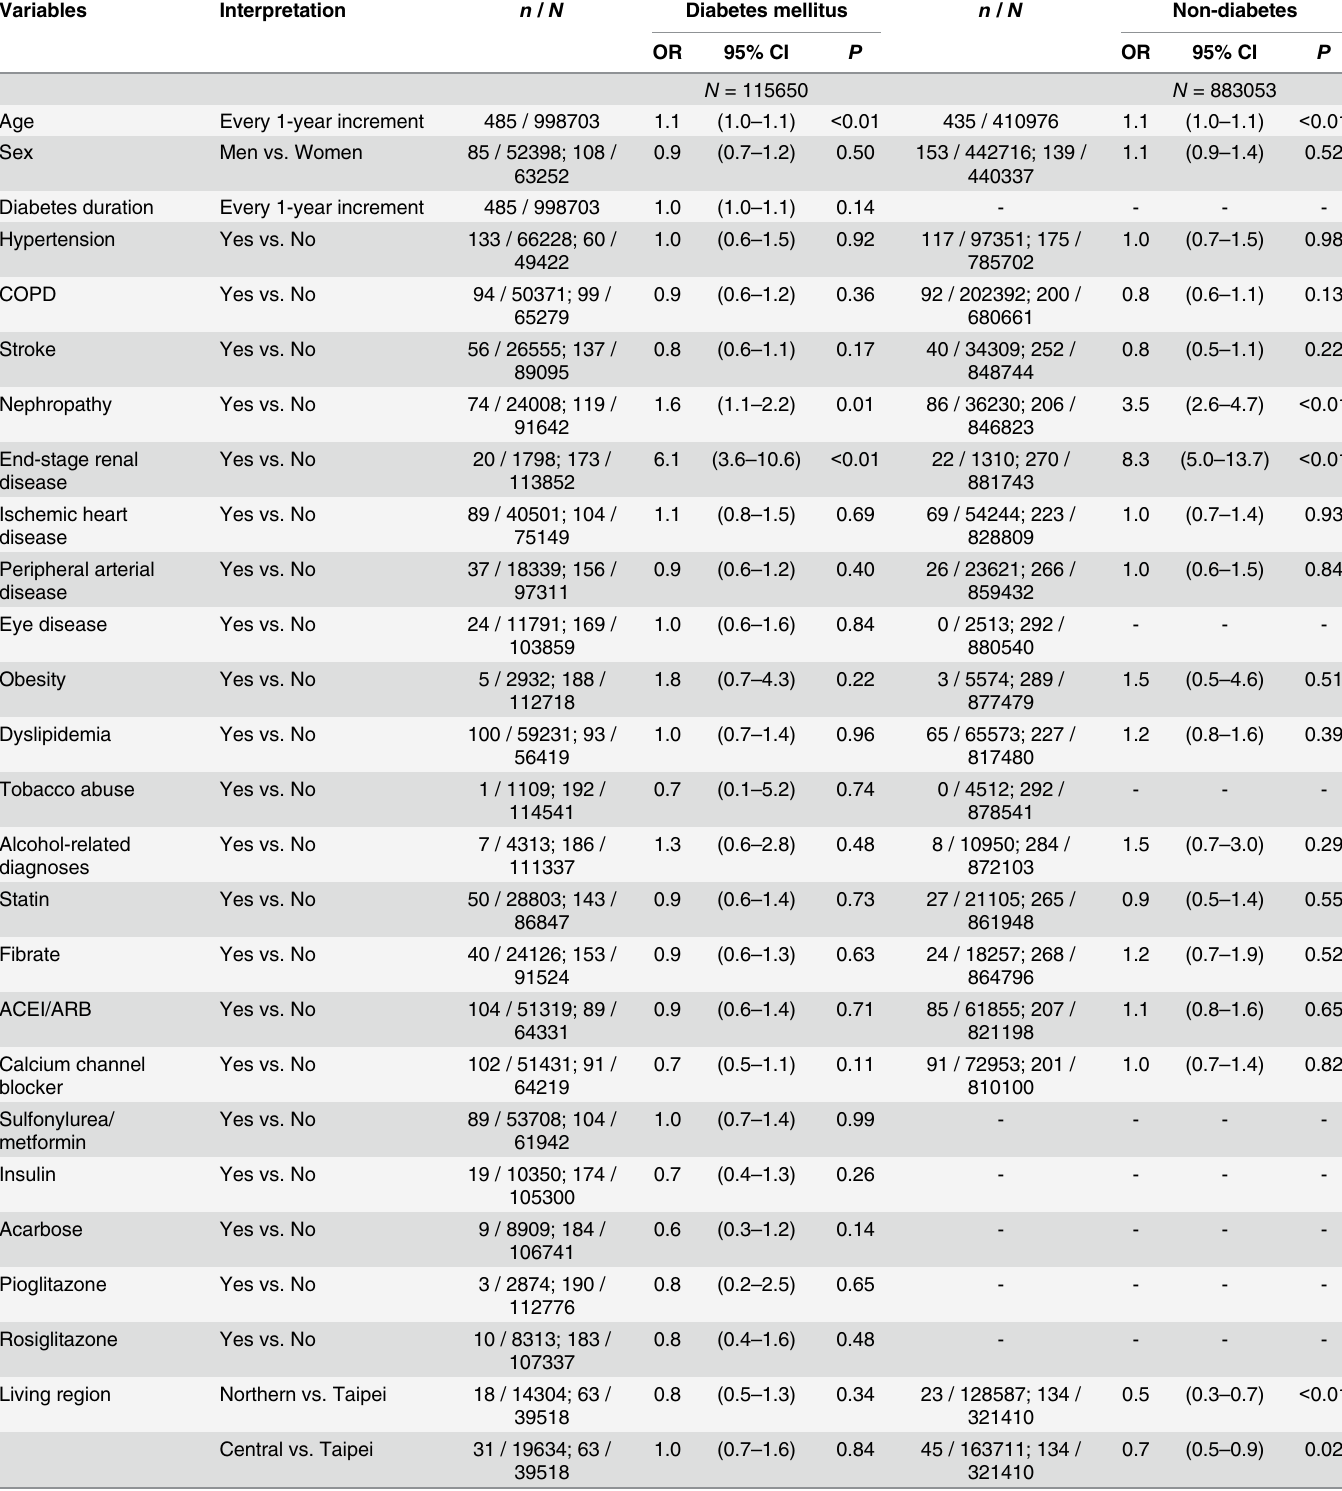
Table 4. Multivariable-adjusted odds ratios for kidney cancer with regards to diabetes